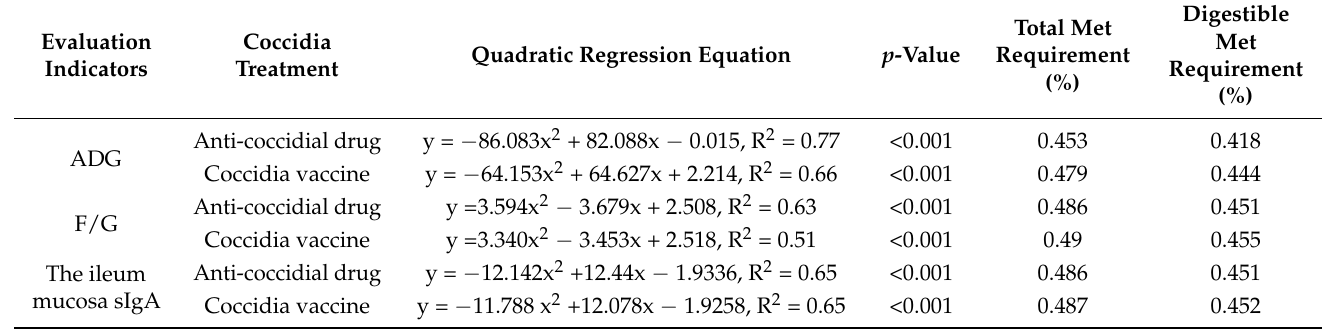
Table 8. The total Met and digestible Met requirements of 1~21 d partridge shank broiler by quadratic regression model